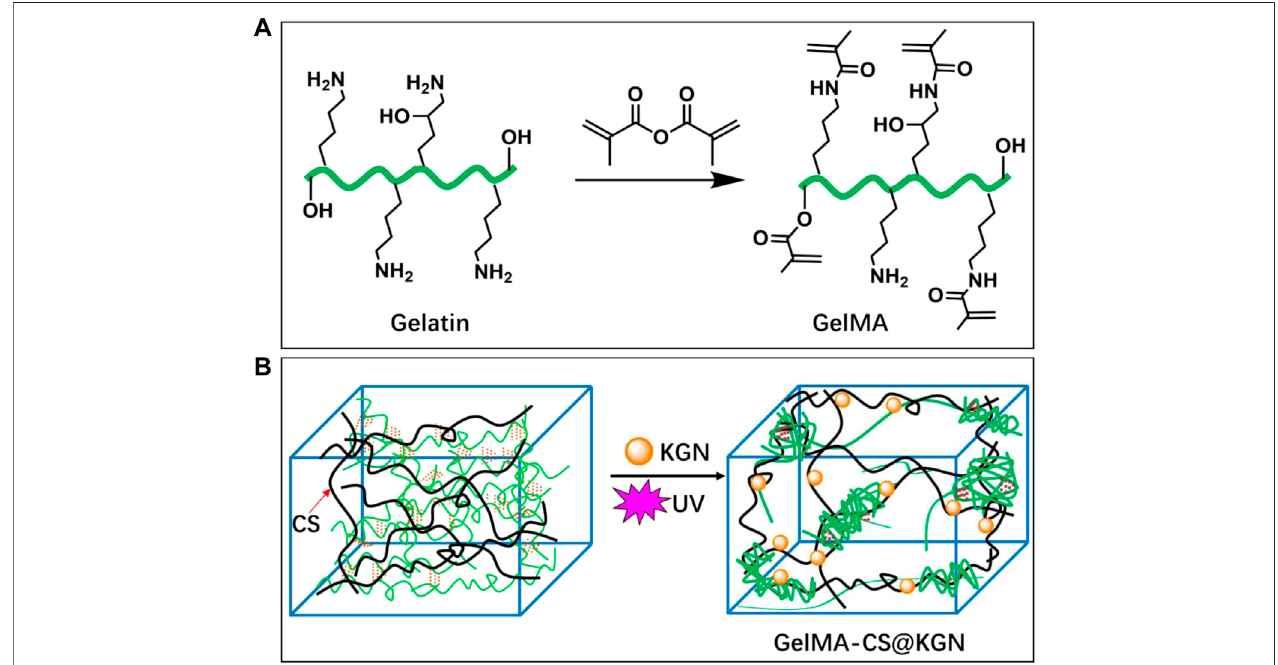
FIGURE 1 | Schematic illustrations of synthesis pathways of (A) GelMA macromolecule and (B) KGN-loaded GelMA-CS@KGN composite hydrogel.